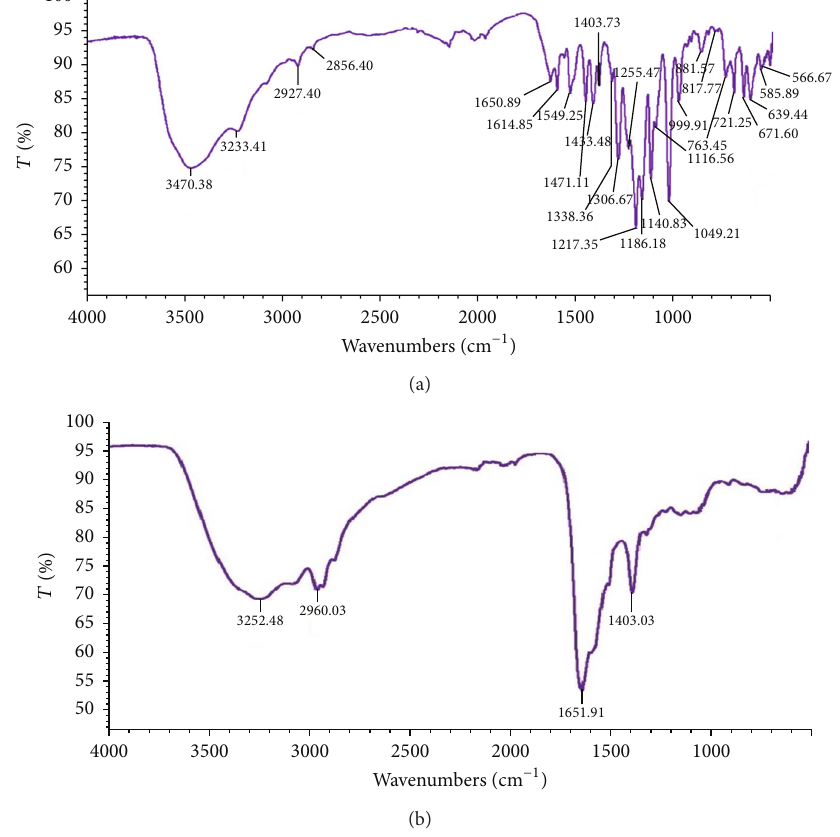
Figure 10: FT-IR spectra of (a) control Reactive Violet 5 and (b) its degradation